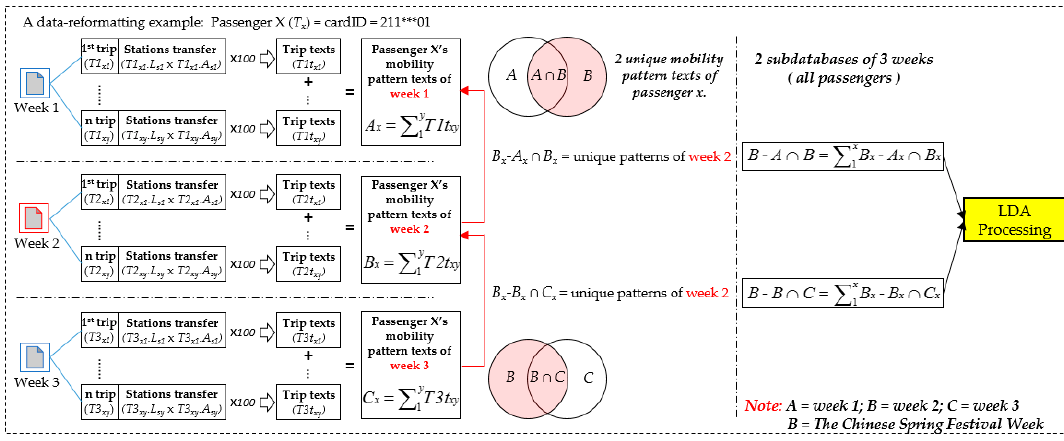
Figure 8. Daily metro smart card swiping frequency of 21 days.